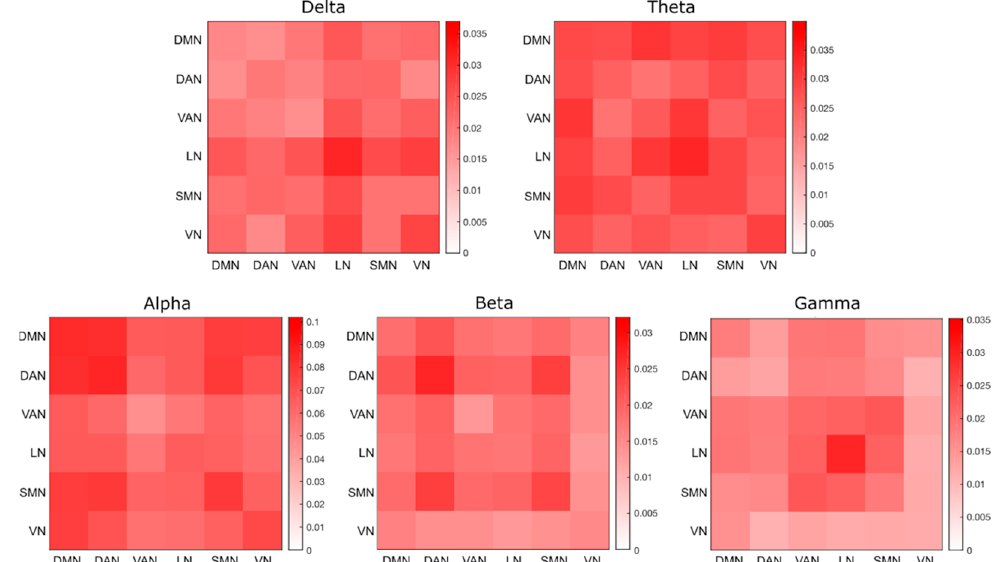
Figure 4. Functional connectivity matrices for the following frequency bands: delta (1–4 Hz), theta (4–8 Hz), alpha (8–13 Hz), beta (13–30 Hz) and gamma (30–80 Hz). In each matrix, the diagonal values represent the group average intra-network connectivity, whereas the off-diagonal values represent the group average inter-network connectivity.